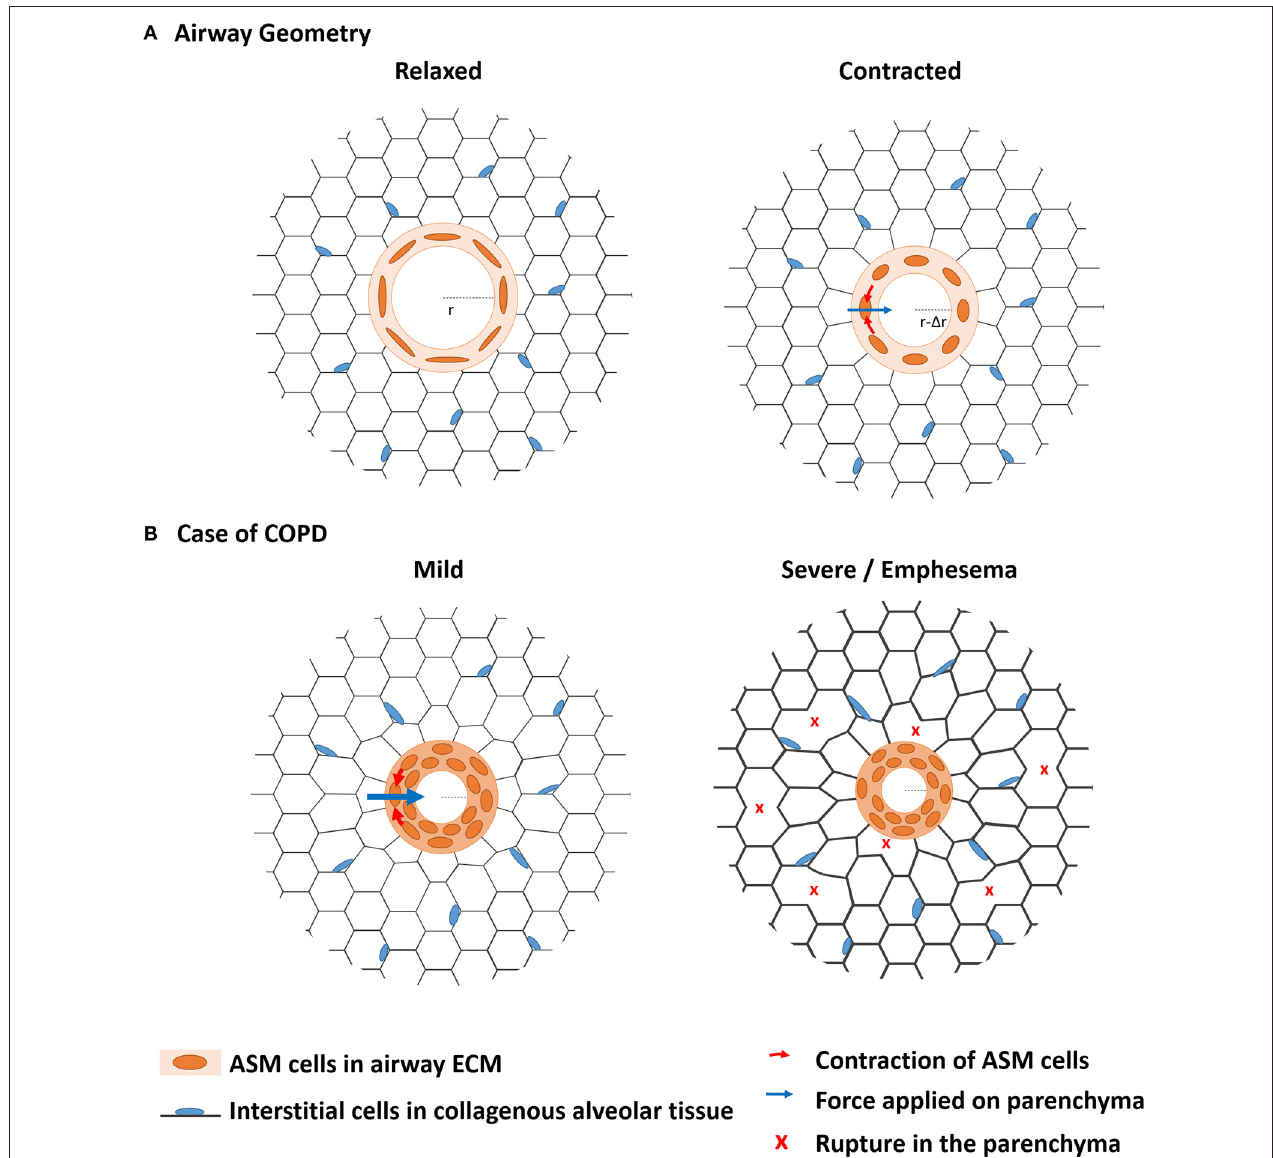
FIGURE 1 | The biomechanics from bronchoconstriction to COPD. (A) The contractile airway smooth muscle (ASM) is embedded in an alveolar tissue called parenchyma. When they contract in reaction to external stimuli, the ASM cells aligned along the perimeter of the airway apply a radial force on the parenchyma, which is deformed. In healthy lungs, the resulting airway narrowing is transient and fully reversible. (B) In case of COPD, chronic inflammation leads to chronic airway hyperresponsiveness (AHR). Airway narrowing is more profound than in healthy lungs so that the ASM gets thicker by cell hypertrophy and ECM remodeling, which prevents full reversibility of airway narrowing. The resulting sustained load expands the remodeling processes to the parenchyma, which mechanical properties are affected up to disruption of the alveolar walls. Emphysema is particularly characteristic of severe